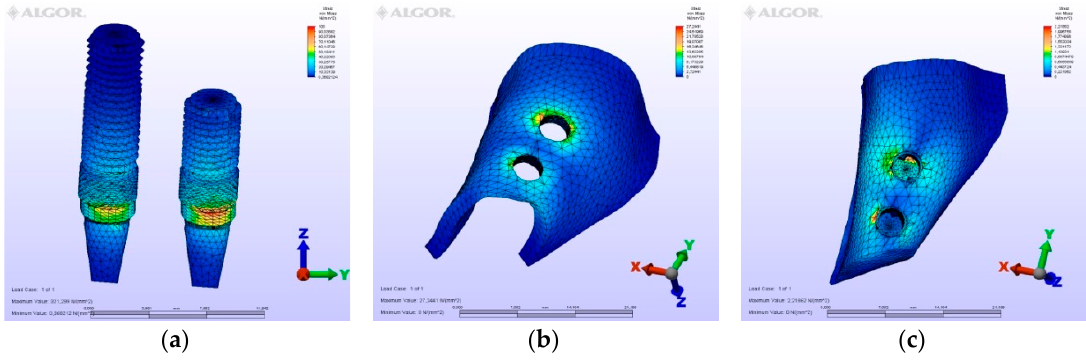
Figure 4. Model M1, horizontal loading. ( a ) the maximum von Mises stresses around implants; ( b ) maximum principle stress in cortical bone; ( c ) maximum principle stress in cancellous bone.